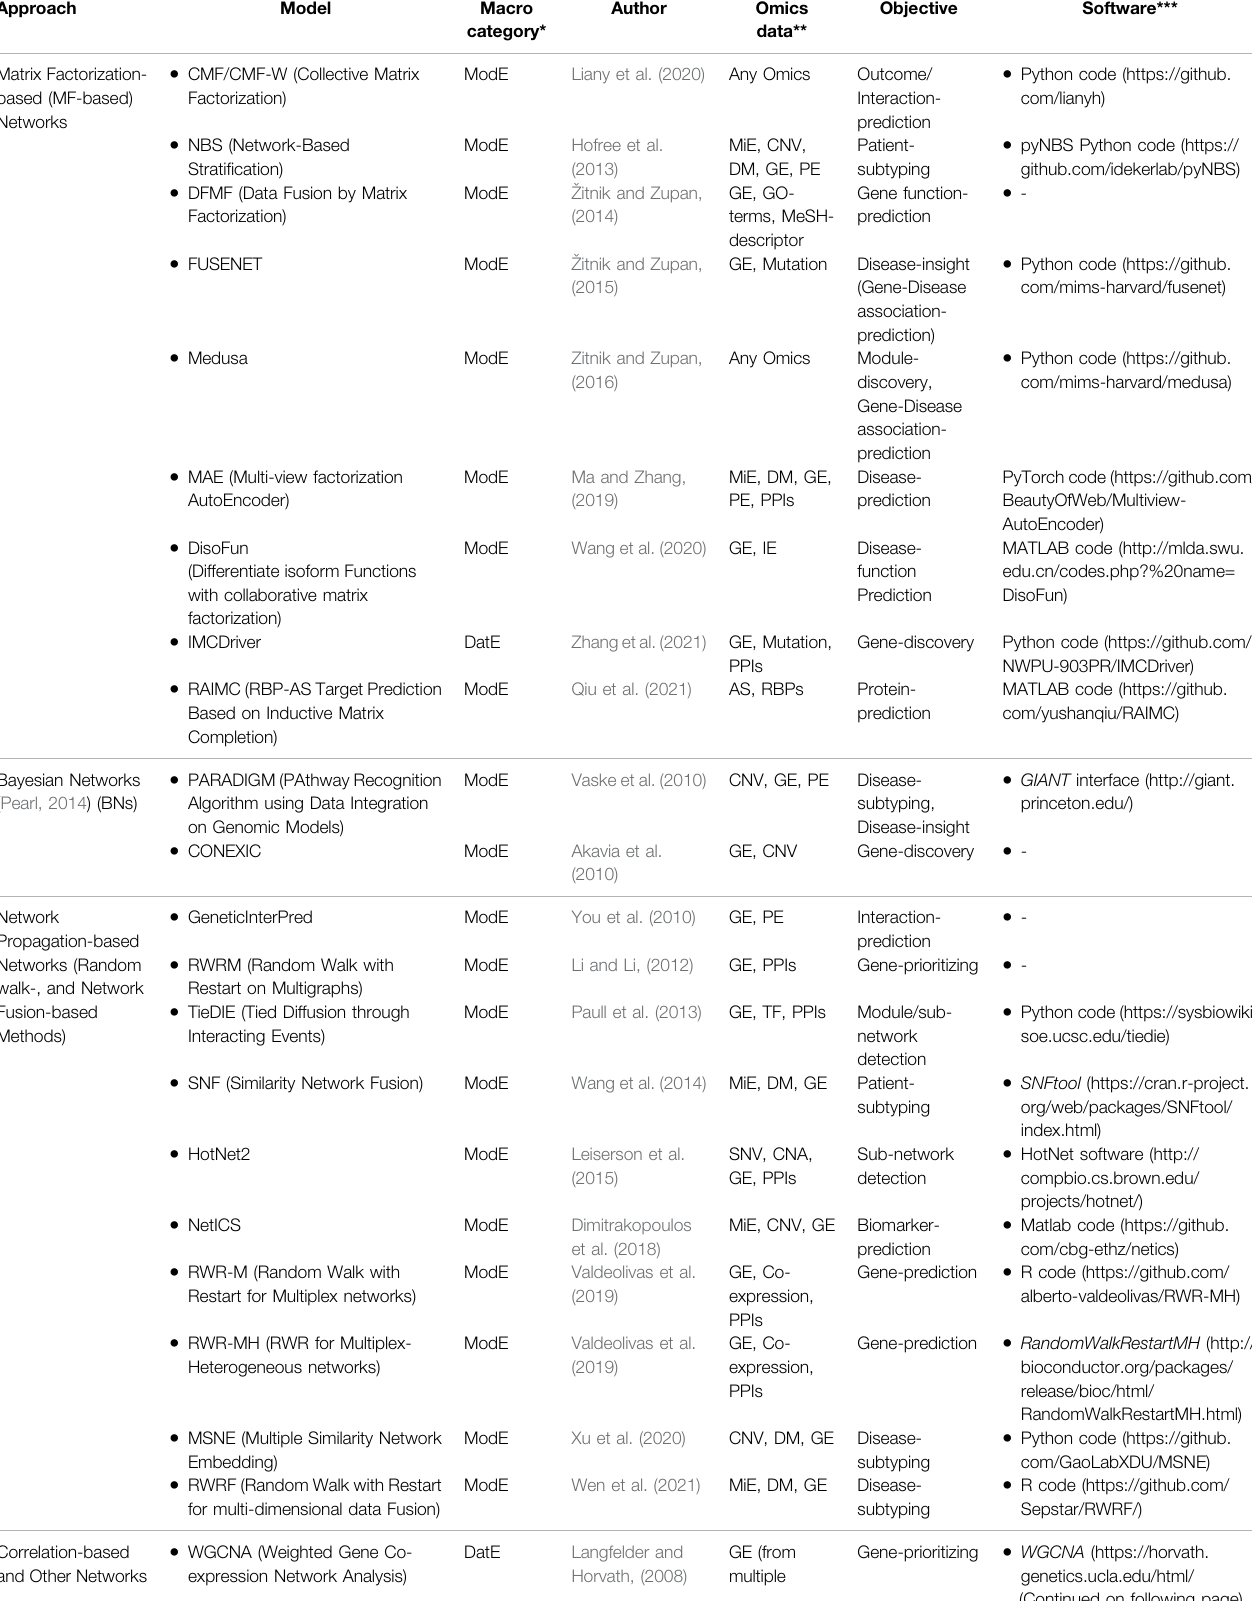
TABLE 4 | Low-level: Network-based unsupervised integration methods.